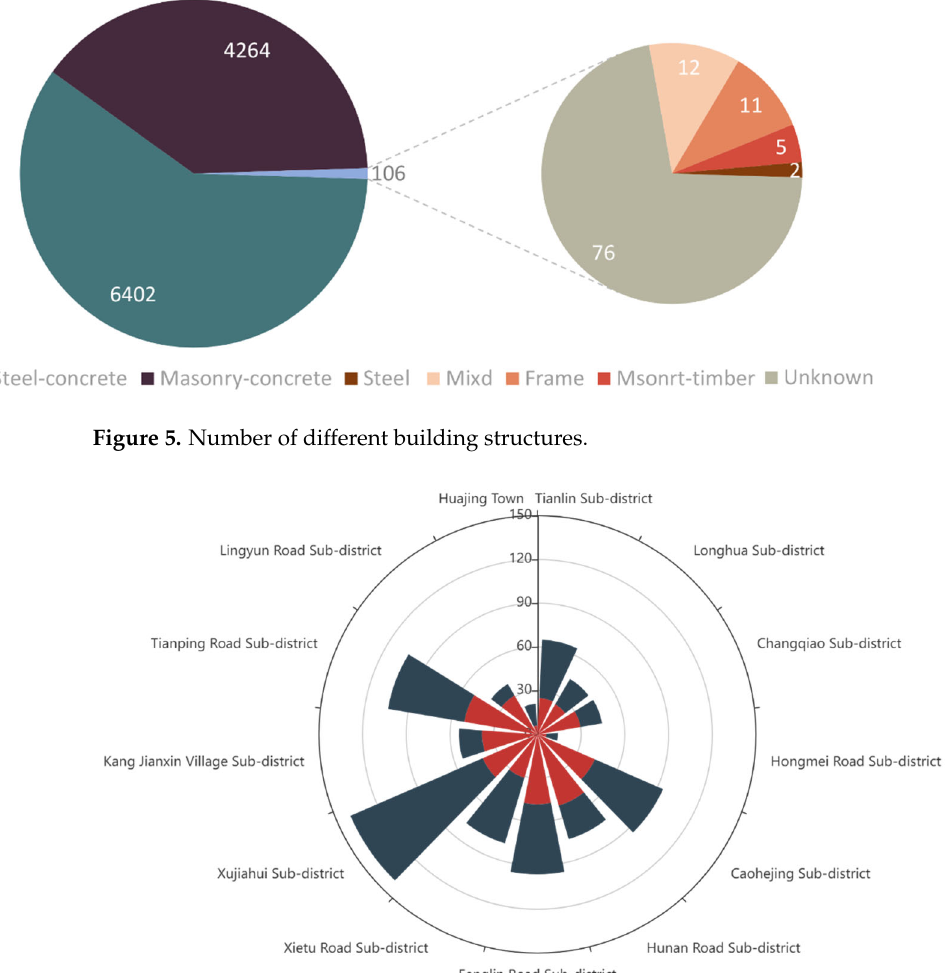
Figure 5. Number of different building structures.